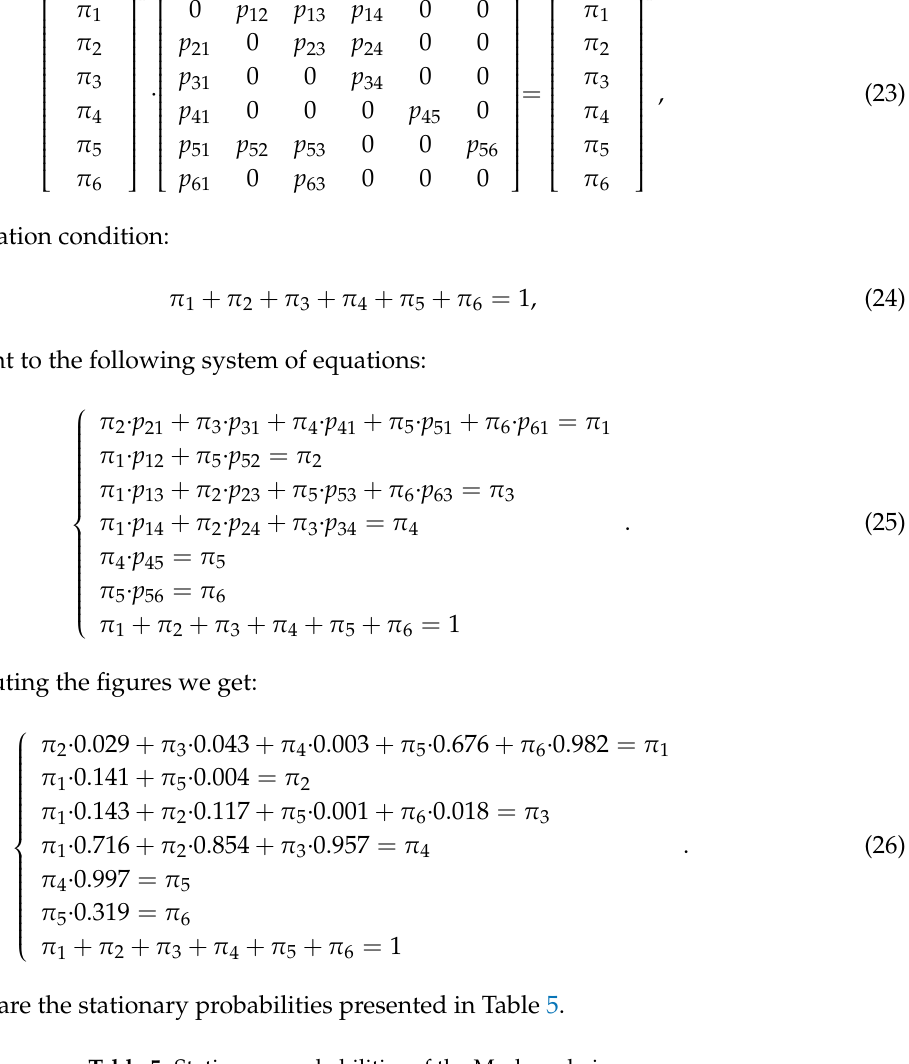
Table 5. Stationary probabilities of the Markov